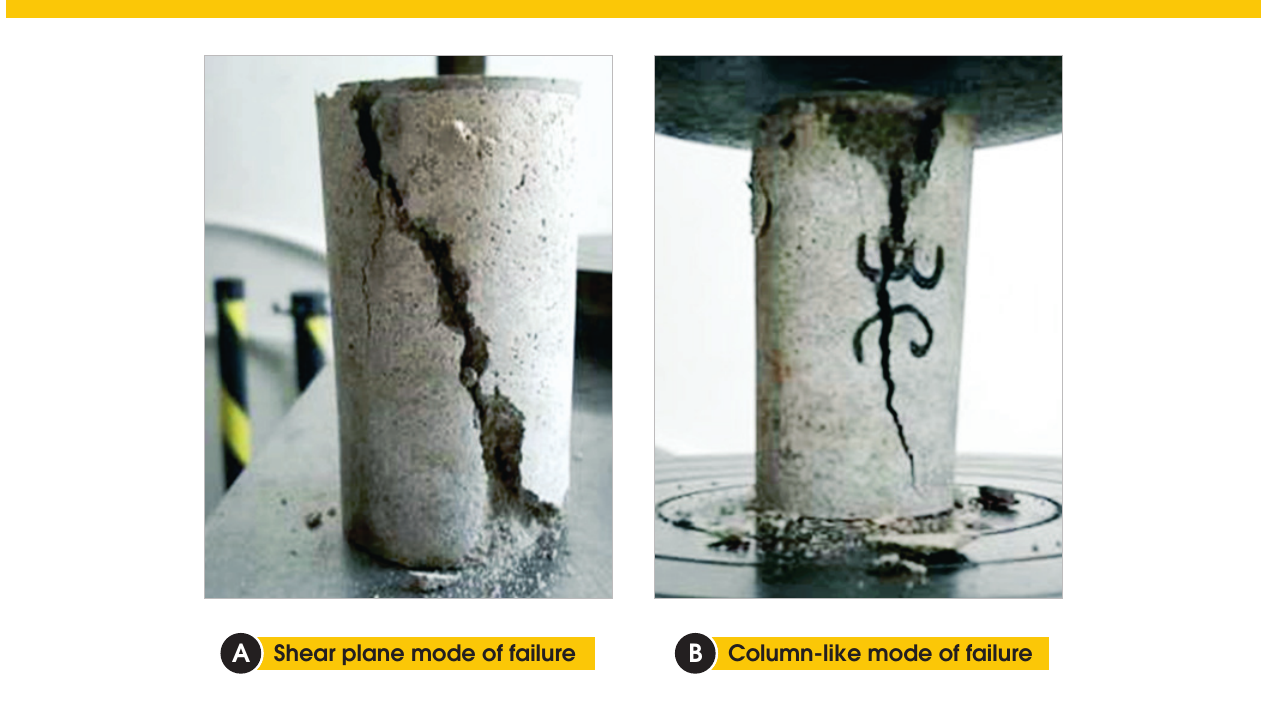
Figure 9 – Cylinder: shear plane mode of failure and column-like mode of failure